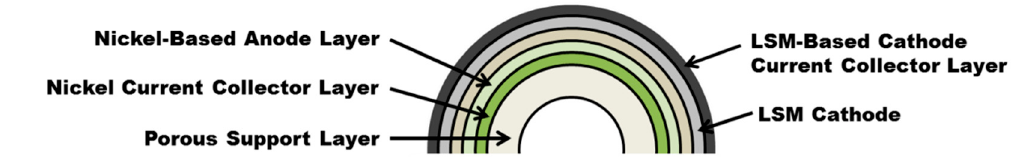
Figure 11. Nickel anode current collecting layer with a porous support cell adapted from [110].